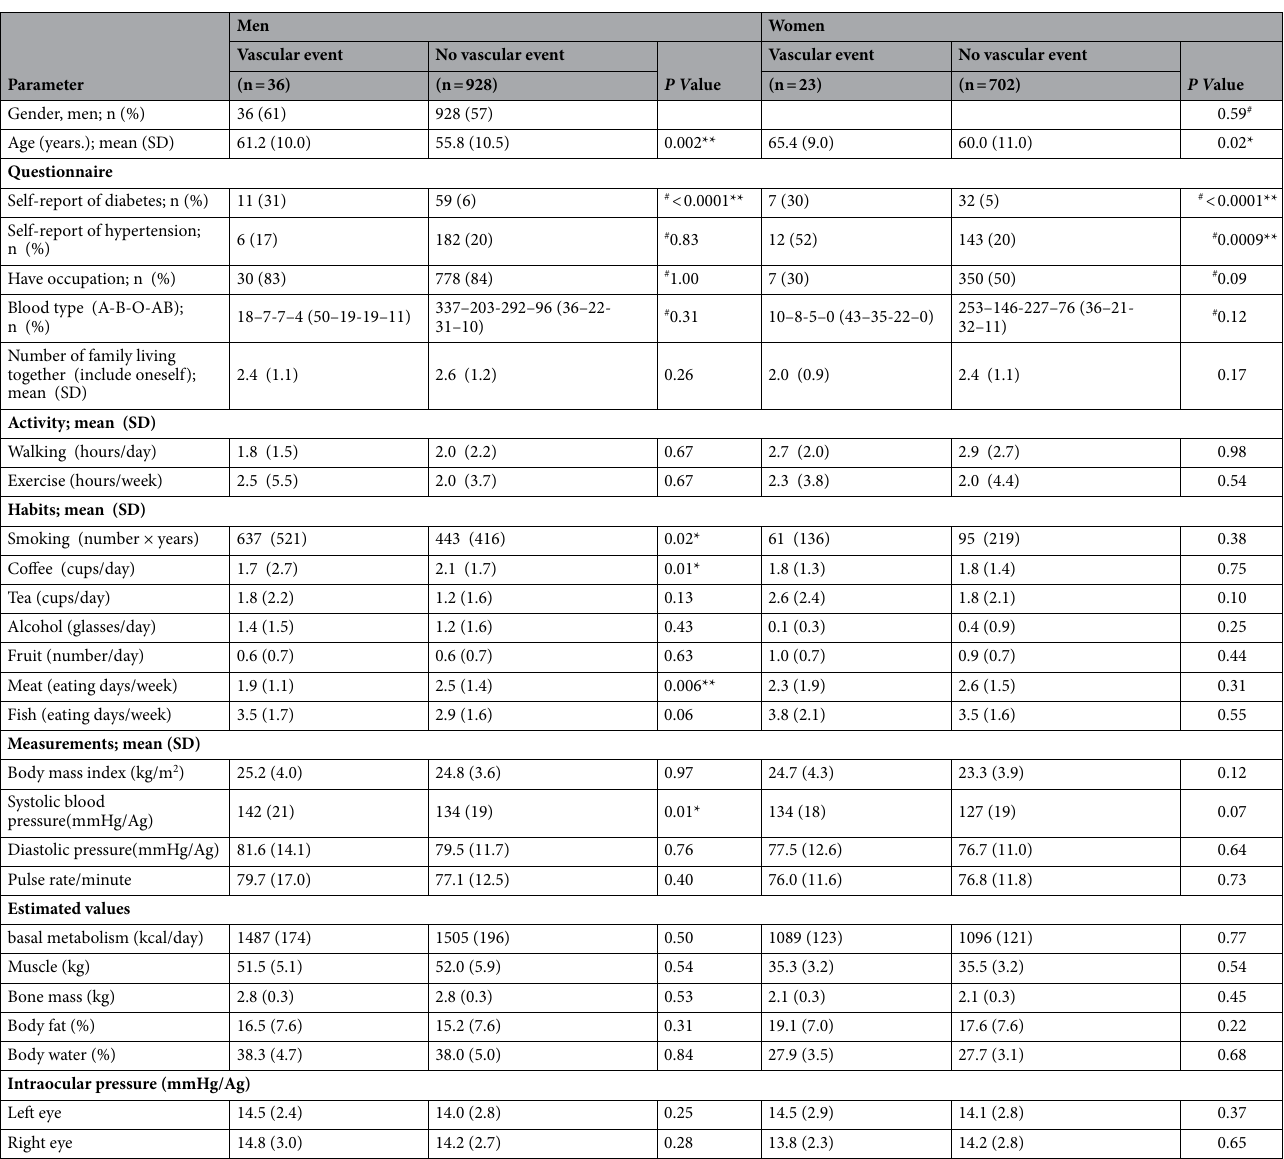
Table 3. Results of univariate comparisons of the participants who had retinal vascular events and those who did not. SD standard deviation * < 0.05; ** < 0.01; # P Value calculated by Fisher’s exact test.; P value without # is calculated by Wilcoxon rank sum